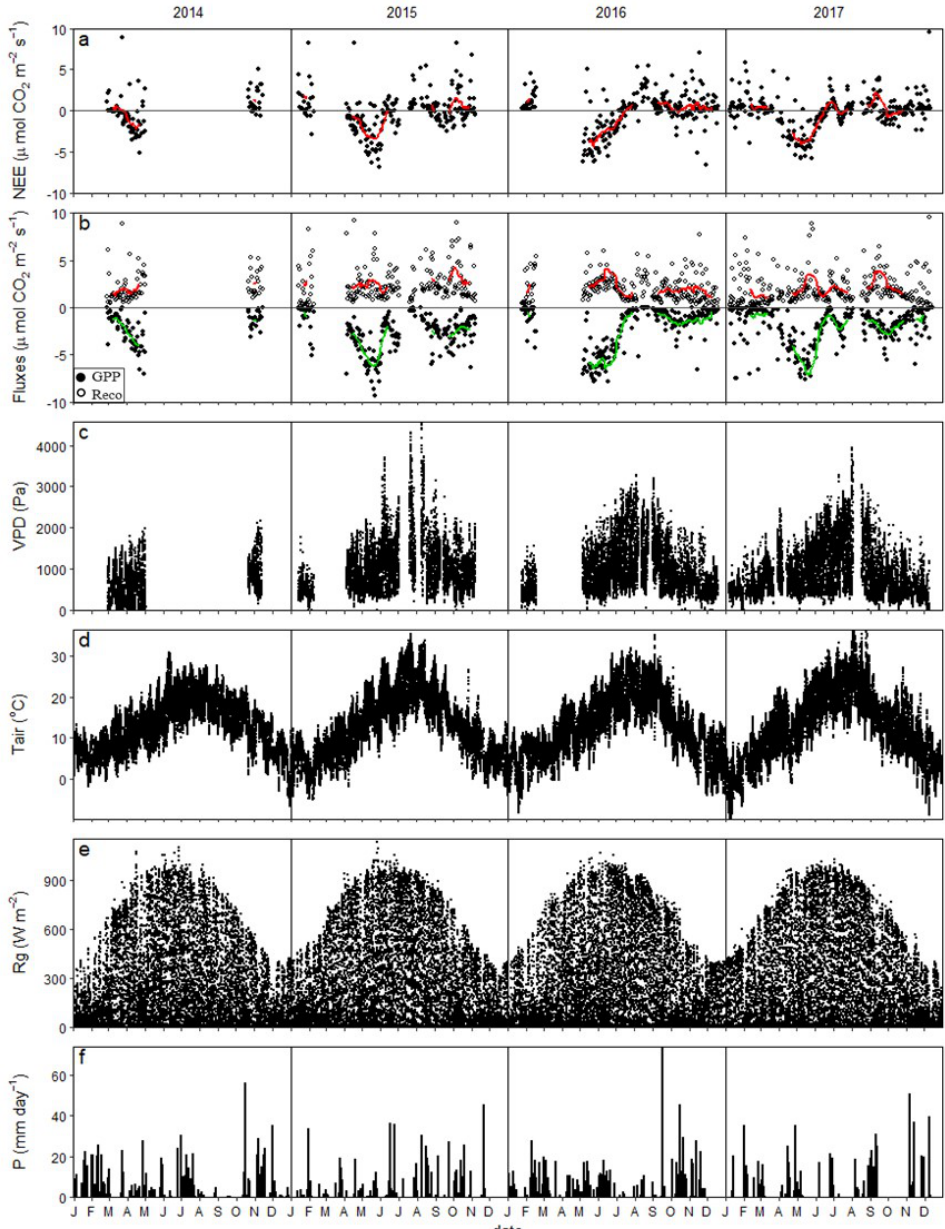
Figure 2. Daily average of NEE ( a ) (the red line represents the moving average of daily NEE with a 20 days window); R eco and GPP ( b ) (the green and red lines represent the moving average of daily GPP and R eco , respectively; 30 min average of VPD ( c ), Tair ( d ), Rg ( e ) and total daily precipitation ( f ) recorded between 2014 and 2017 at the study site.